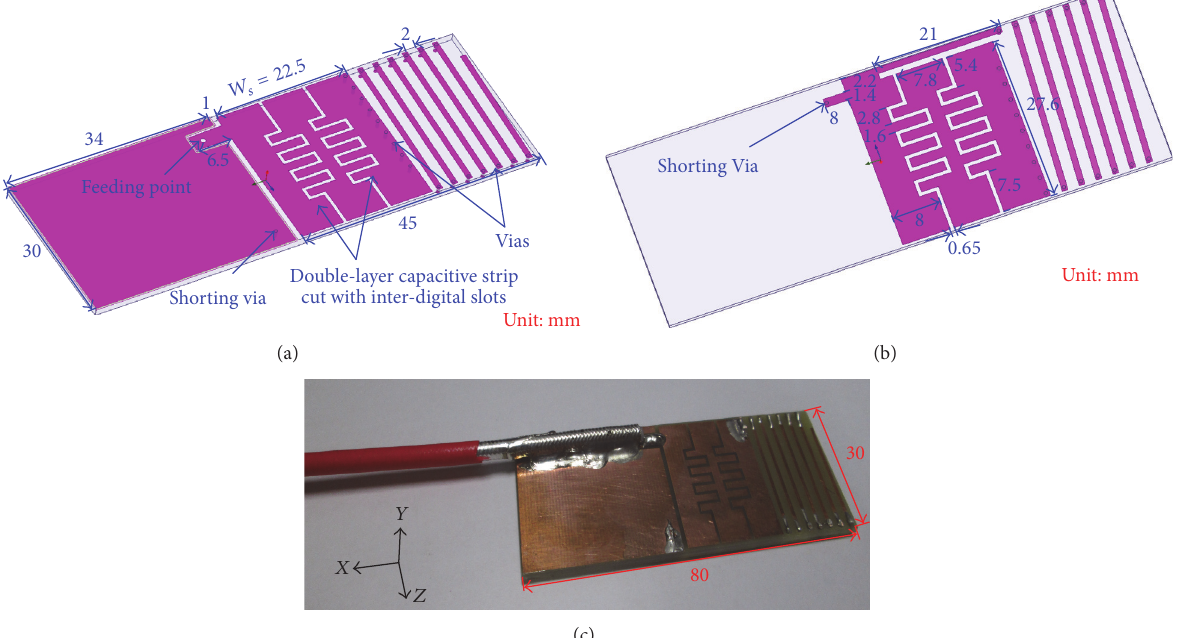
Figure 1: Configuration of the proposed antenna on a 1.6-mmFR-4 substrate. (a) Top side, (b) bottom side, and (c) photo of the antenna prototype top